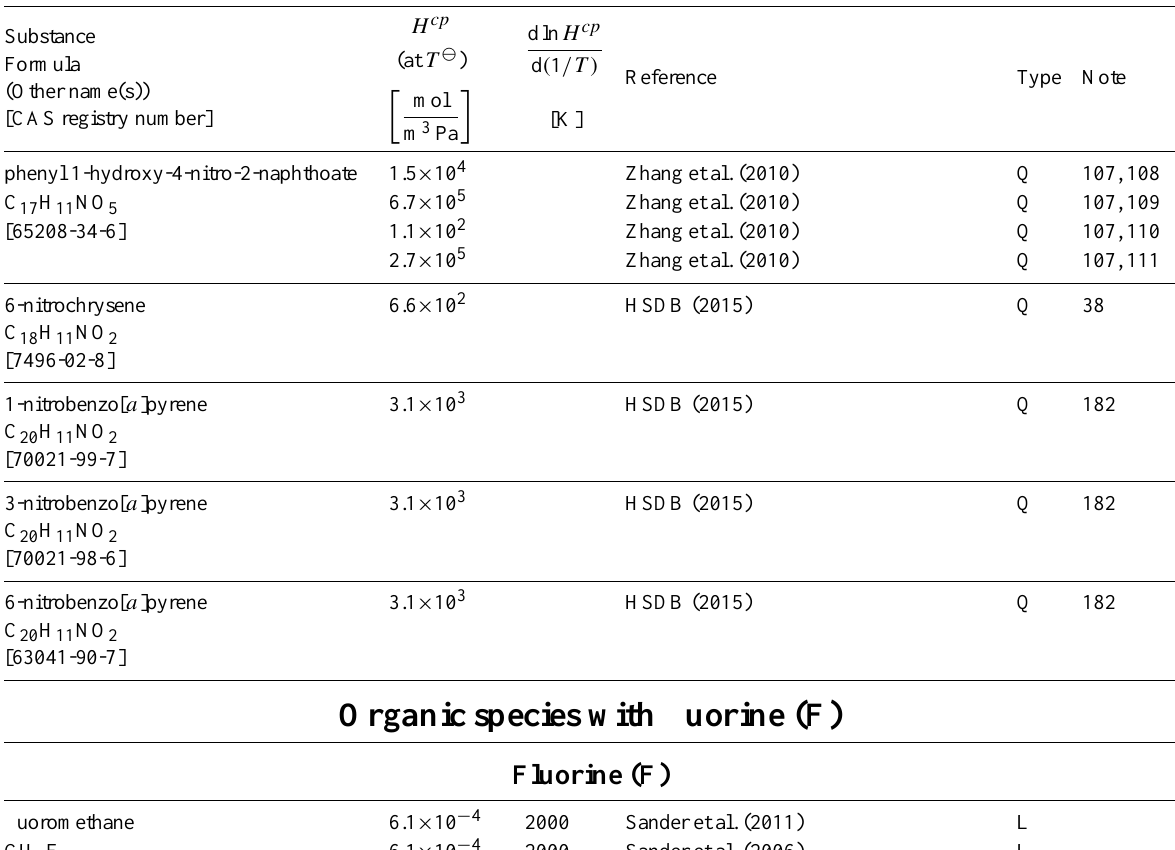
Table 6: Henry’s law constants for water as solvent